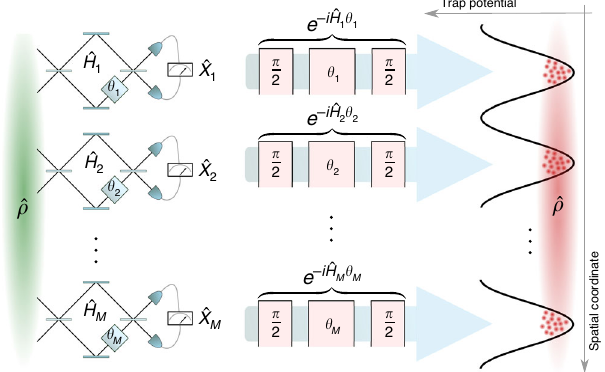
Fig. 2 Local vs nonlocal atomic spin squeezing. For a local parameter encoding with N = 100 particles, nonlocal squeezing, described by Eq. (14), leads to a larger quantum sensitivity gain for either the sum T Σ = n T Σ n 10 log (continuous blue line) or the difference of two 10 ð n þ Þ SN n þ þ þ T Σ = n T Σ n spatially distributed parameters 10 log (dashed blue 10 ð n (cid:2) Þ SN n (cid:2) (cid:2) (cid:2) line) than local squeezing, Eq. (15). Since the spin-squeezing matrix is diagonal when squeezing is local, both combinations of parameters, as well as their uncorrelated average, yield the same sensitivity (red dashed line). Nonlocal squeezing yields a lower quantum gain for the uncorrelated Σ = Tr Σ Þ (dashed – dotted line). The plot shows data for average 10 log 10 ð Tr SN local directions r 1 and r 2 chosen to maximize the gain for the sum. A local rotation transforms the sum of parameters into the difference and vice